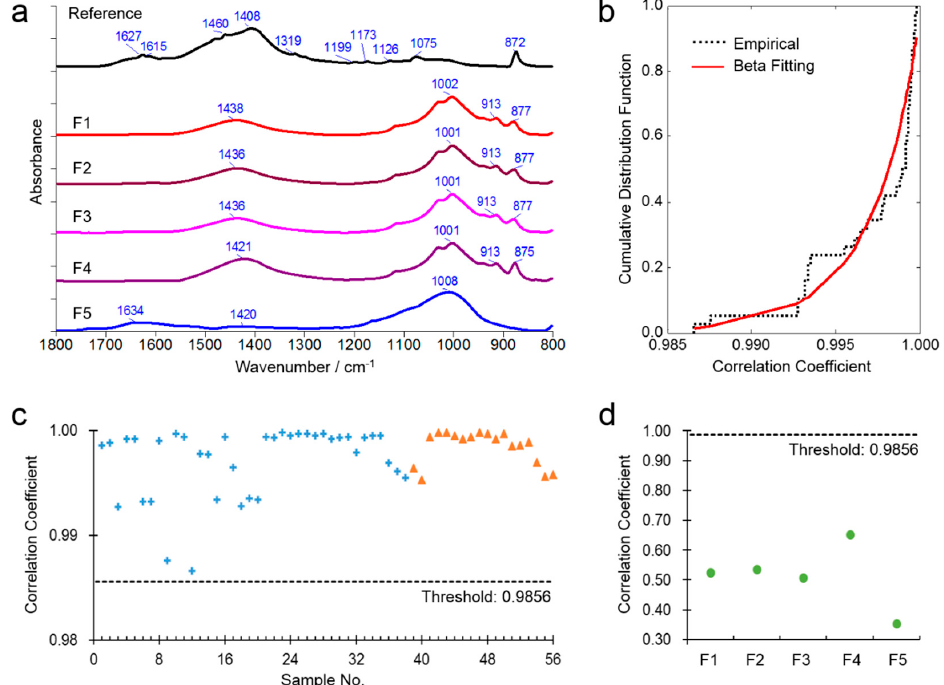
Figure 3. Correlation-based FTIR identification of Indigo Naturalis. ( a ) ATR-FTIR spectra of the reference and the fake samples F1–F5; ( b ) Cumulative distribution of the correlation coefficients of the true samples against the reference; ( c ) Correlation-based FTIR identification of the calibration true samples ( + ) and validation true samples ( ▲ ); ( d ) Correlation-based FTIR identification of the fake samples.